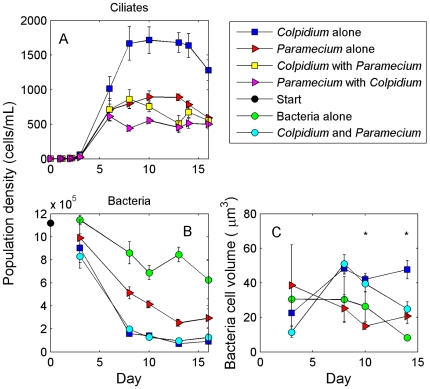
Population and size dynamics of protists and bacteria.(A) Population density of the Colpidium striatum and Paramecium aurelia in single and two-species communities and (B) density of the prey bacteria, Bacillus subtilis, in the different treatments. Colpidium and Paramecium coexisted in the two-species community, with Colpidium numerically dominant. Colpidium grazed B. subtilis to lower levels than Paramecium, but the overall population density of bacteria was similar between Colpidium and the two-species cultures. In (C), the estimated cell volume of Bacillus subtilis is shown by treatment, sampled four times during the course of the experiment (days 3, 8, 10, and 14). As time passed, a pattern of size-differentiation developed where the mean size of the bacteria increased in the Colpidium treatment and decreased in the Paramecium treatment. Differences between size of bacteria in the Colpidium and Paramecium treatments were nearly significant on day 8 and significant on days 10 and 14 (noted by asterisk). This indicates that Colpidium selected smaller bacteria than Paramecium, which is evidence of size-based resource partitioning between the two species.